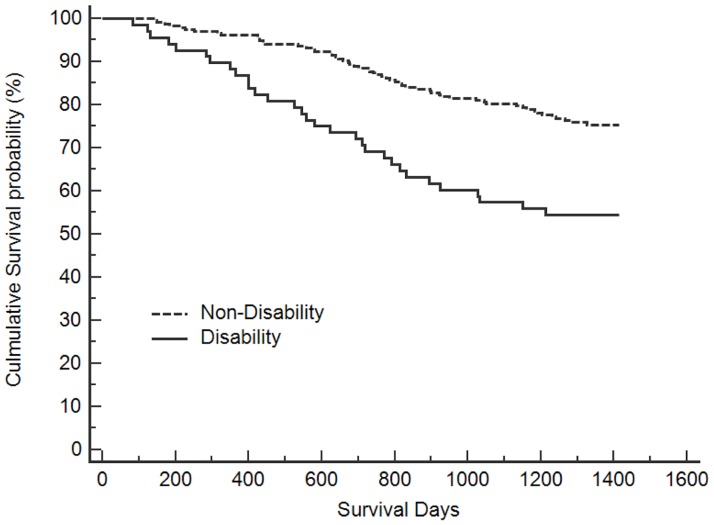
Kaplan-Meier unadjusted survival estimates according to disability status.